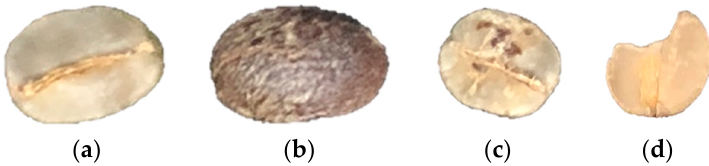
Figure 4. The appearance of healthy and defective beans. ( a ) Healthy bean, ( b ) defective bean (black bean), ( c ) defective bean (insect damaged bean), and ( d ) a defective bean (broken bean). 1. Healthy beans: The entire post-processed bean should appear free of defects. The color of the beans should be blue-green, light green, or yellow-green, as shown in Figure 4a. 2. Black beans: Black beans appear darkened before harvest or fully fermented, as shown in Figure 4b, and produce a turbid and putrefactive odor in coffee [7,8]. 3. Insect damaged beans: The insect damaged bean shown in Figure 4c is a result of coffee cherry bugs laying eggs on a coffee tree and the hatched larvae biting the coffee drupes to form wormholes. This type of defective bean produces a turbid odor or strange taste in coffee. 4. Broken beans: Figure 4d shows a bean that was damaged during the treatment process or transportation, known as “ruptured beans”. It is likely to induce non- uniform baking [9].